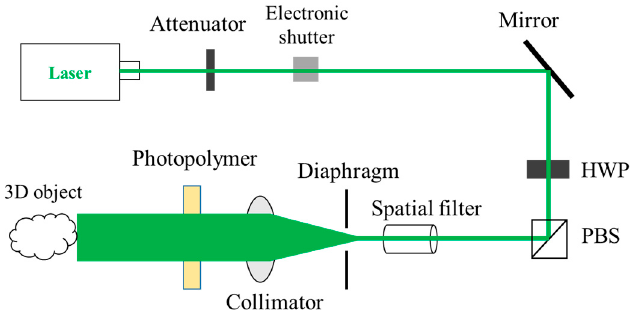
Figure 6. Monochromatic reflective volume holographic recording optical setup.